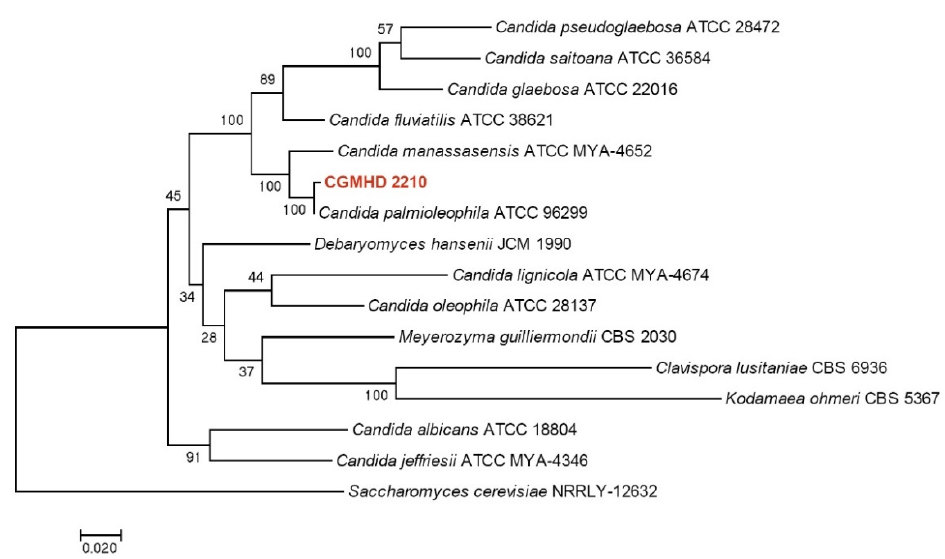
Figure 4. Micrograph showing isolated cells of the yeast C. palmioleophila (scale bar = 10 μ m).